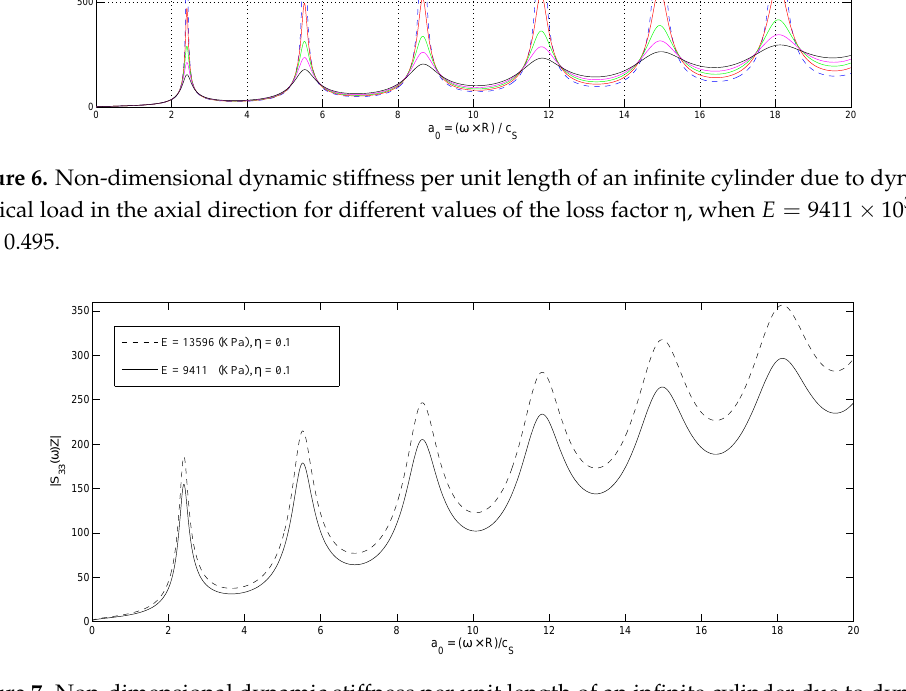
Figure 7. Non-dimensional dynamic stiffness per unit length of an infinite cylinder due to dynamic vertical load in the axial direction for different values of the Young’s modulus E = 9411 × 10 3 and E = 13596 × 10 3 when loss factor η = 0.1 and ν = 0.495.